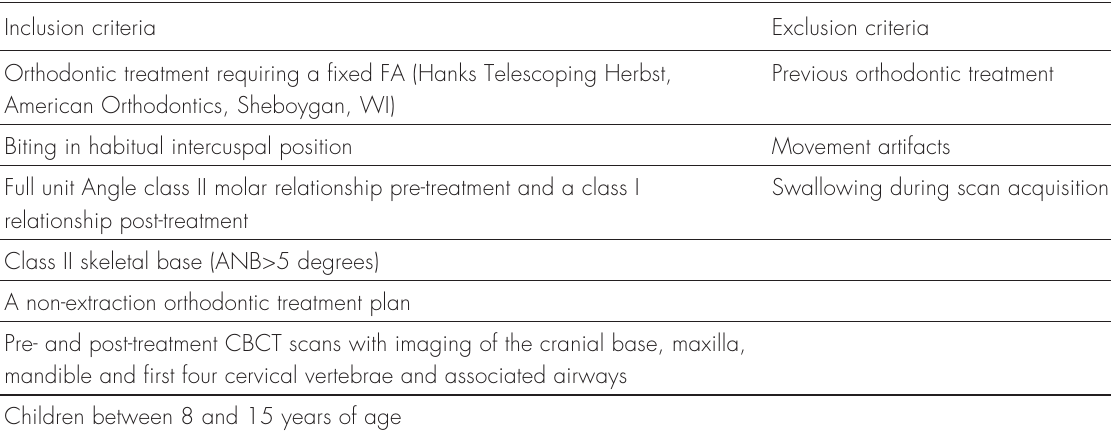
Table I. Inclusion and exclusion